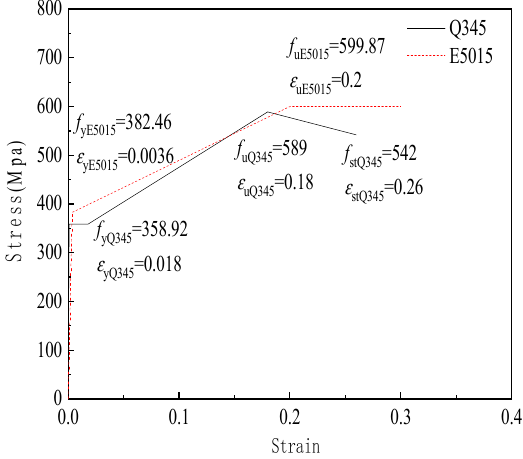
Figure 11. Material constitutive model.